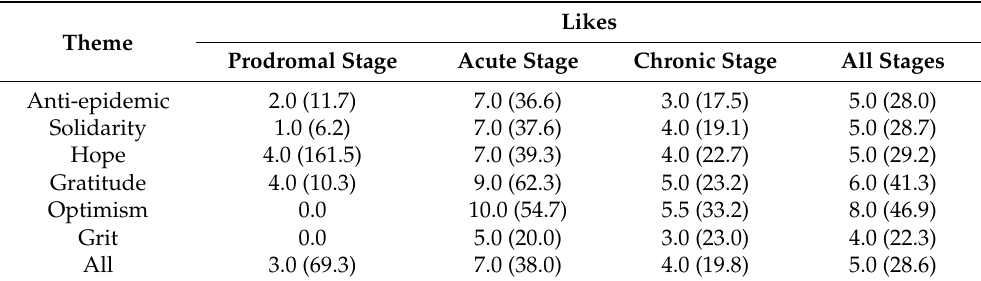
Table 2. Public engagement across different crisis stages and posting themes (1 January to